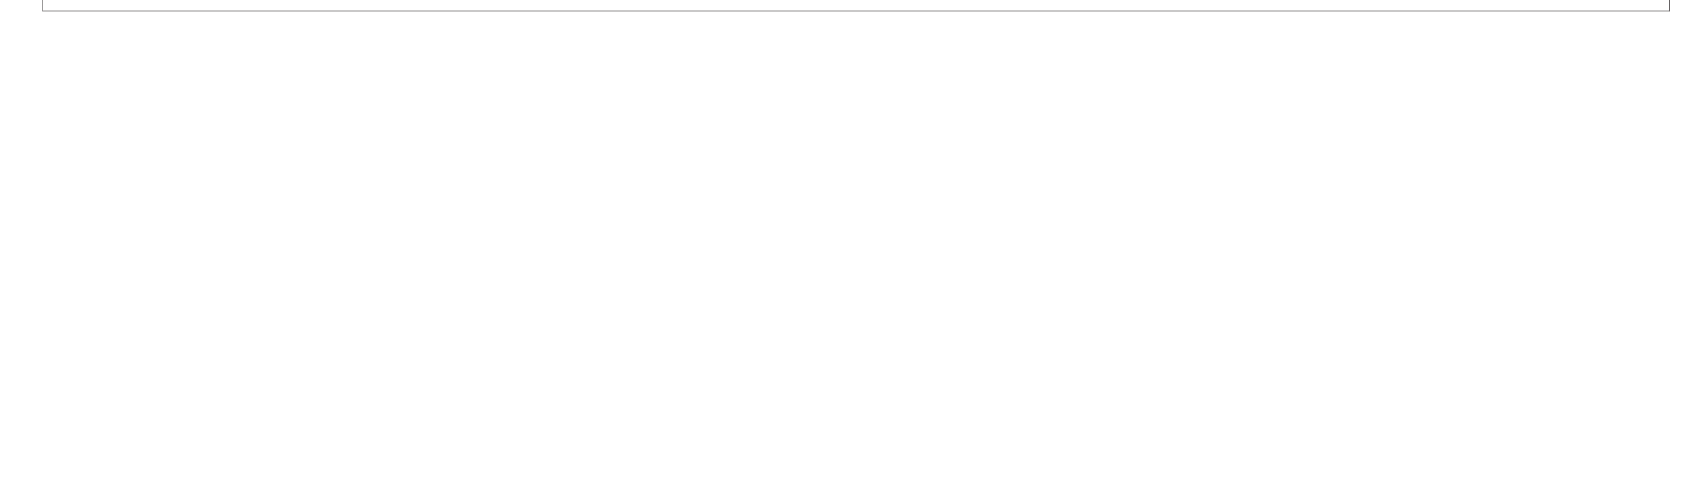
FIGURE 1 | (A) The species trees and distributions of gut microbial communities. (B) A Venn diagram showing OTU similarities and differences among the